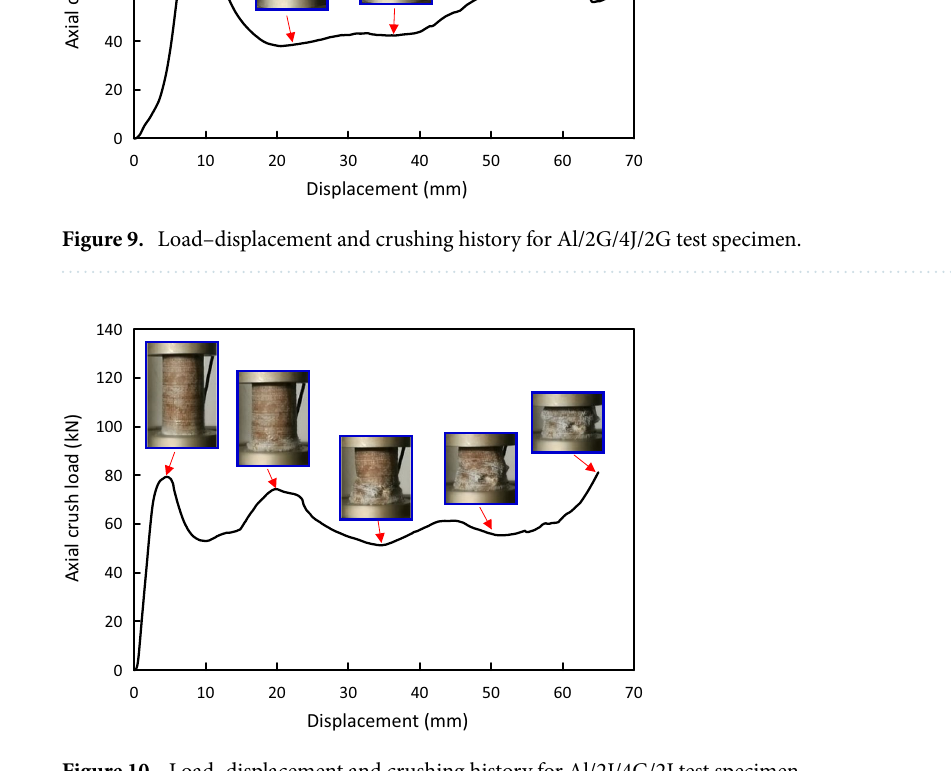
Figure 10. Load–displacement and crushing history for Al/2J/4G/2J test